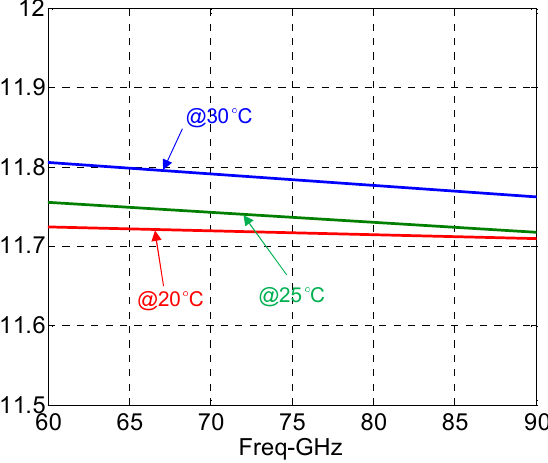
Figure 9. The temperature dependent permittivity in the E-band using the fifth fitting. Table 2. A comparison of the measured permittivity of undoped silicon.